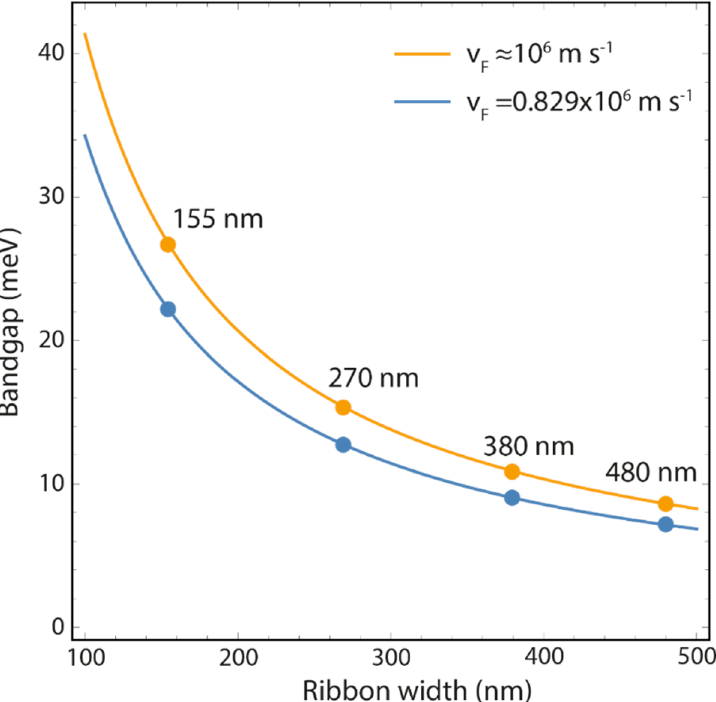
Figure 3. Bandgap ( Δ ) as a function of the ribbon width (w). Markers represent the GNR systems under study and the continuous line is the fitting curve using Equation (2). The numerical values of the bandgap and effective mass are calculated using two different charge carrier velocities: v F = 0.829 × 10 6 m s − 1 (blue markers) and v F = 1.0 × 10 6 m s − 1 (orange markers) and reported in Tables S2 and S3.